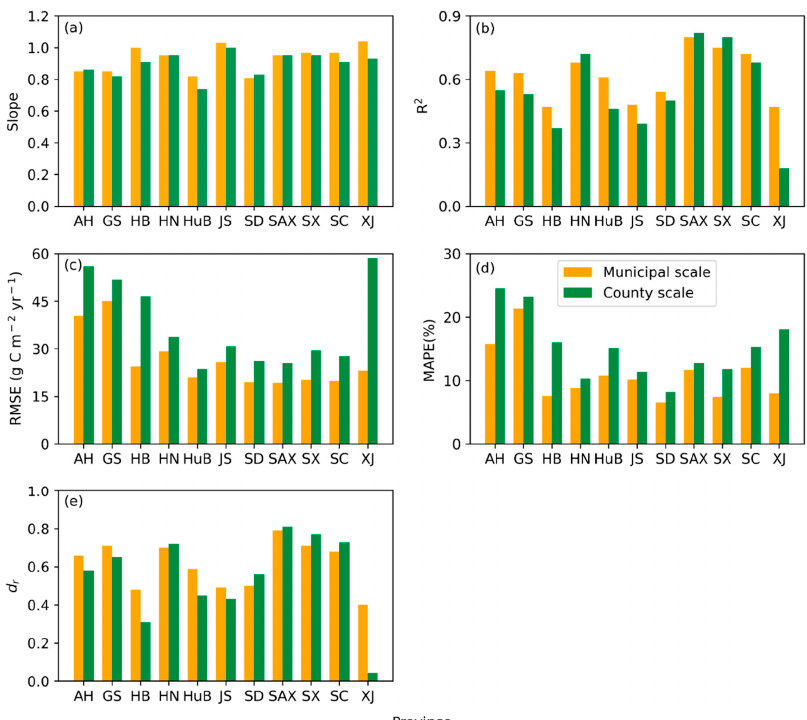
Figure 5. Comparison of model performance at municipal and county scales. ( a – e ) show the slope, R 2 , RMSE, MAPE and d r between statistical and estimated yield at municipal and county scales, respectively.